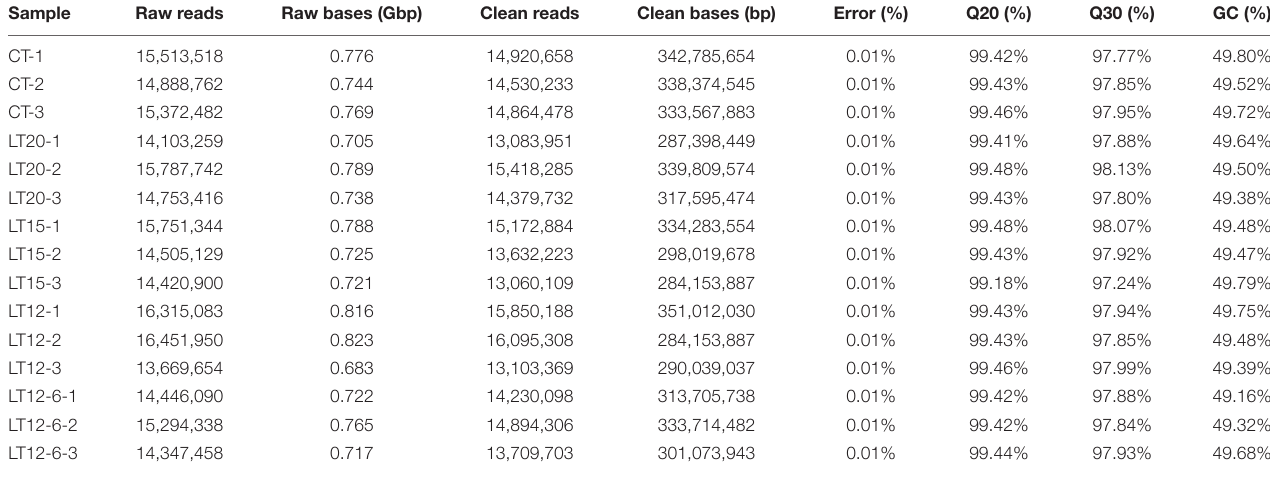
TABLE 2 | Detailed summary of miRNA